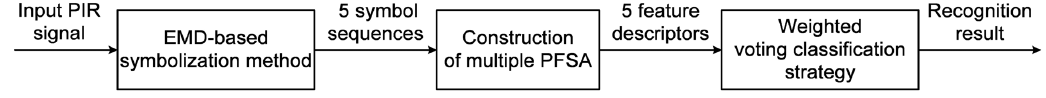
Figure 4. Constitution of the EMD-based symbolic time series analysis.